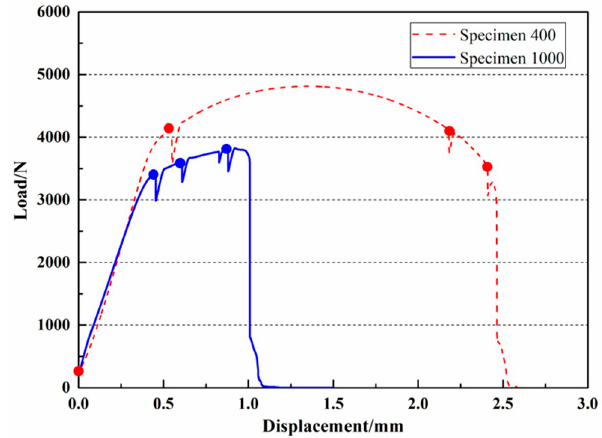
Figure 2. Load-displacement curves for the specimens fabricated at di ff erent scanning speeds.